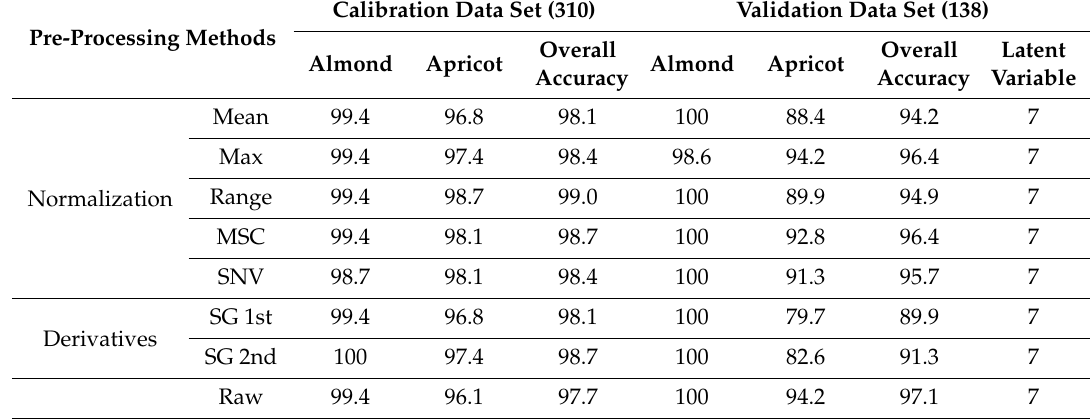
Figure 6. The partial least square discrimination analysis (PLS-DA) classification plots for almonds and apricot seeds based on the raw preprocessing.